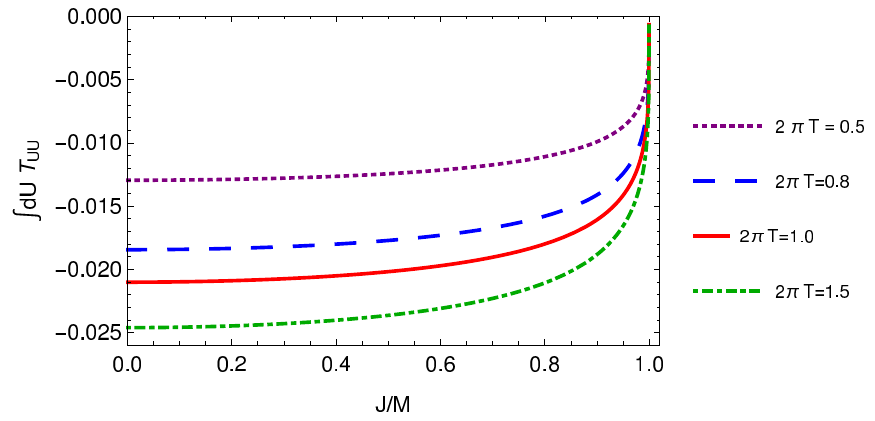
Figure 2 . Average null energy at (cid:12)xed temperatures as a function of angular momentum. We have set (cid:1) = 0 :